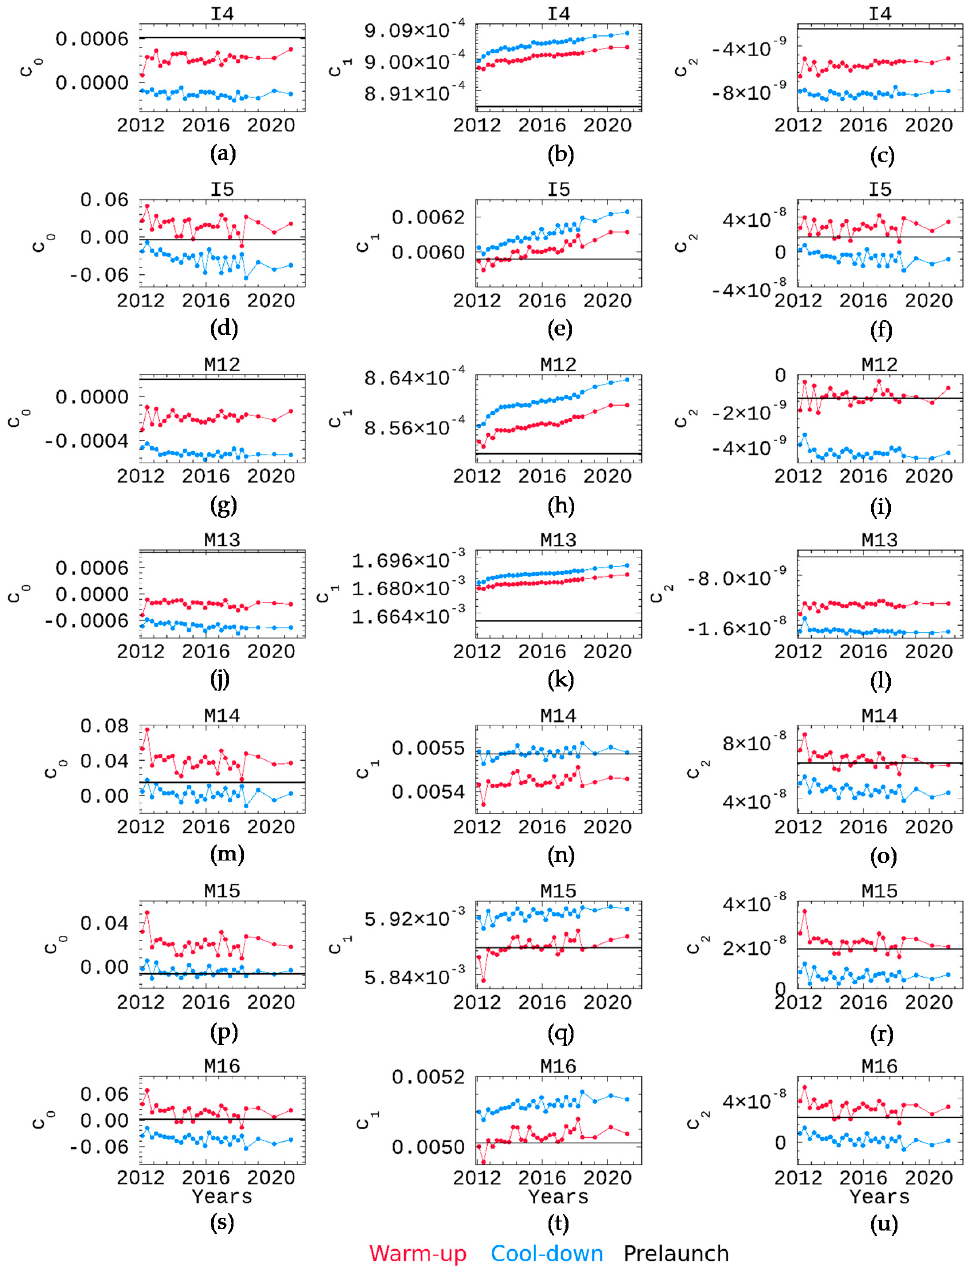
Figure 10. S-NPP VIIRS TEB band-averaged on-orbit-derived ( c 0 on − orbit , c 1 on − orbit , and c 2 on − orbit ) calibration coefficients for ( a – c ) I4, ( d – f ) I5, ( g – i ) M12, ( j – l ) M13, ( m – o ) M14, ( p – r ) M15, and ( s – u ) M16 over the entire mission. Results are separated into WU and CD processes. Prelaunch coefficients are also included and defined by horizontal black lines. Only HAM-side A is